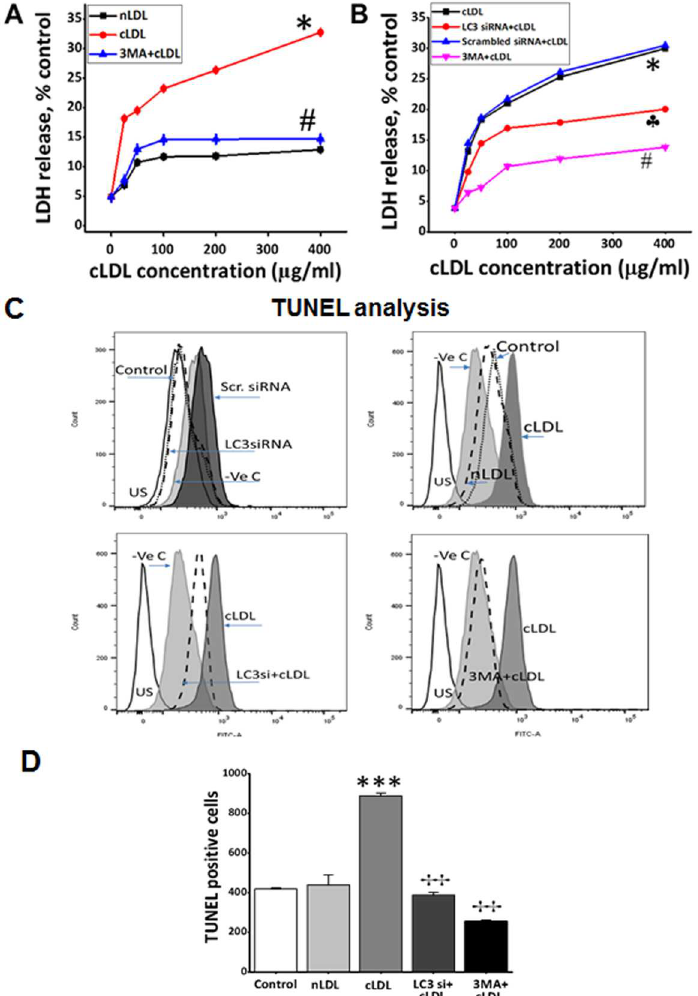
Fig 5. Effect of inhibition of cLDL-induced autophagy on cell death and DNA fragmentation in HCAE cells. (A) LDH release by cells after treatment with 5mM autophagy inhibitor3MA and (B) LC3 β siRNA transfection. ( A) HCAE cells were treated with different doses of cLDL or nLDL with and withoutautophagy inhibitor 3MA for 8h as shownand mediawere collectedfrom these cultures and analyzedfor LDH releaseas described in Method section. (B) HCAE cells were transfectedfor 48 h LC3 β siRNA or LC3 β Scr. siRNA and treated with and without different doses of cLDL for 8h as shown.Cells were also treated with different doses of cLDL with and without autophagy inhibitorfor 8h as shown. Followingtreatments, media were collectedfrom these cultures and analyzedfor LDH releaseas describedin Method section.The data presentedshows cLDL dose-dependenceon LDH releasein HCAE cells comparedto untreatedcontrol cells. The expressedvalues are means ± SD.(n = 6). As shown,same doses of nLDL had no effect or very slight (~12%)on LDH release with the highest dose. Significantly (# p < 0.05) lower LDH releasewas recordedin the groupwhen cells were pretreated with 5mM of 3MA beforeadditionof cLDL, or transfectedwith LC3 β siRNA († p > 0.05), in comparison to cLDL- treated alonegroup. (C) Effect of autophagy inhibitionon cLDL-induced DNA fragmentation in HCAE cells as measuredby TUNEL assay. HCAE cells were transfectedwith LC3 β siRNA/ LC3 β scr.siRNA as shownabove followedby treatment with 100 μ g/ml nLDL or 100 μ g/ml cLDL for 8 h. After treatments with LC3 β siRNA/LC3 β scr.siRNA and cLDL (left panels),or CLDL/nLDLwith and without autophagy inhibitor3MA (right panels),apoptoticintensity of HCAE cells was determinedby flow cytometry after TUNEL assay. Histogramsshows the number (counts) of TUNEL positivecells in different groups as measured by flow cytometry. The overlappedpeak demonstrates the effects as a whole. Data are shownas a logarithmic histogramand expressedas fluorescence intensityof numberof counts of the TUNEL-positive cells obtainedfrom the statistical analysisof the fluorescence height and mean value of the x-axis displayedby the software. For positivecontrols fixed and permeabilized cells treated with DNAse and negativecontrols withoutFITC labelingreagent were used. (D) Quantitativeanalysisof the counts of TUNEL-positive endothelial cells of each treatment is presentedas the mean ± SDof three independent experiments ( *** p < 0.001as compared to untreatedcontrols, †† p < 0.001as comparedto cLDL treated